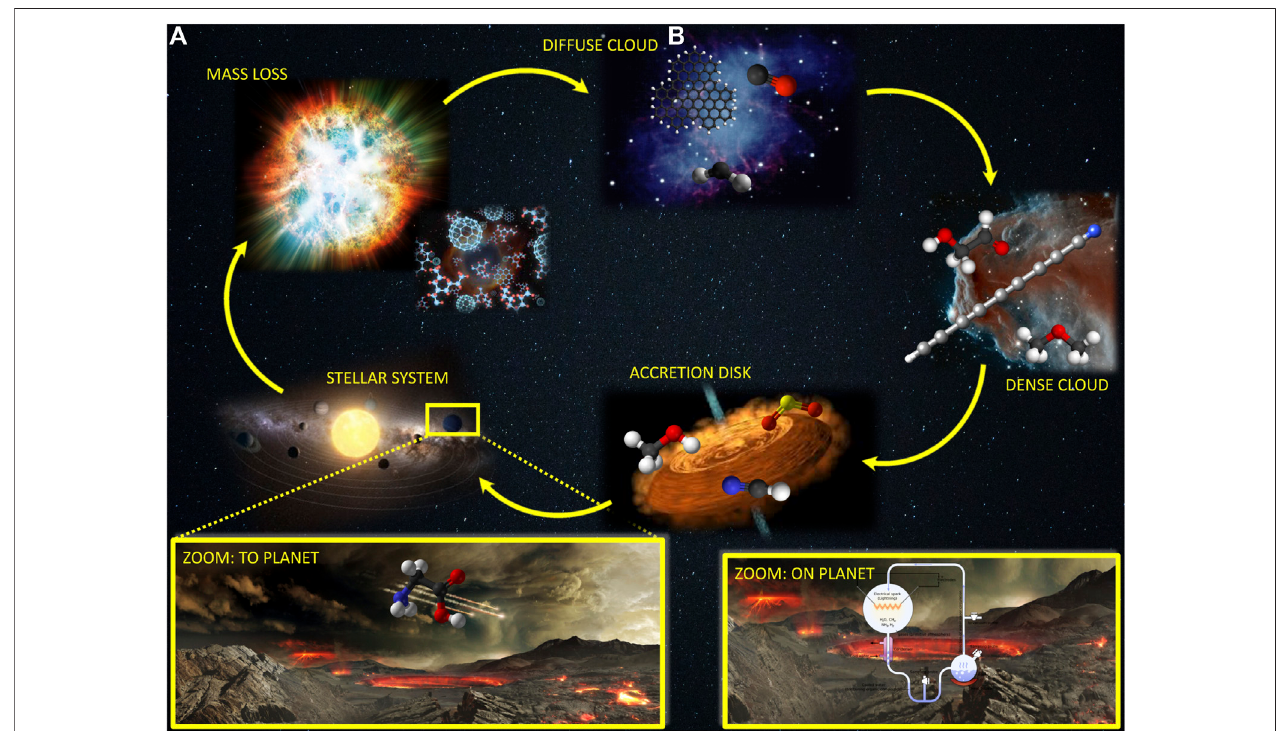
FIGURE1| Lifecircleofastarandthecorrespondingmolecularcomplexity.Intheinsets:Thedeliveryofpre-biologicalmoleculestoEarth (A) andtheirsynthesisin the early Earth (B) .